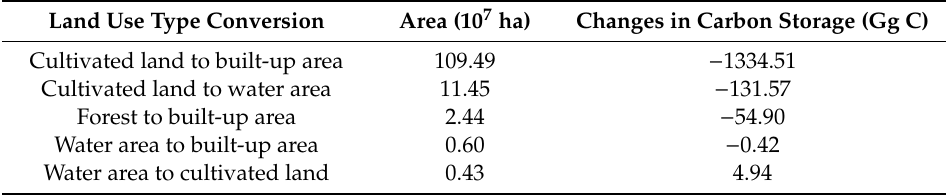
Table 9. The effects of the conversion of the main land-use types on carbon storage from 2000–2010.